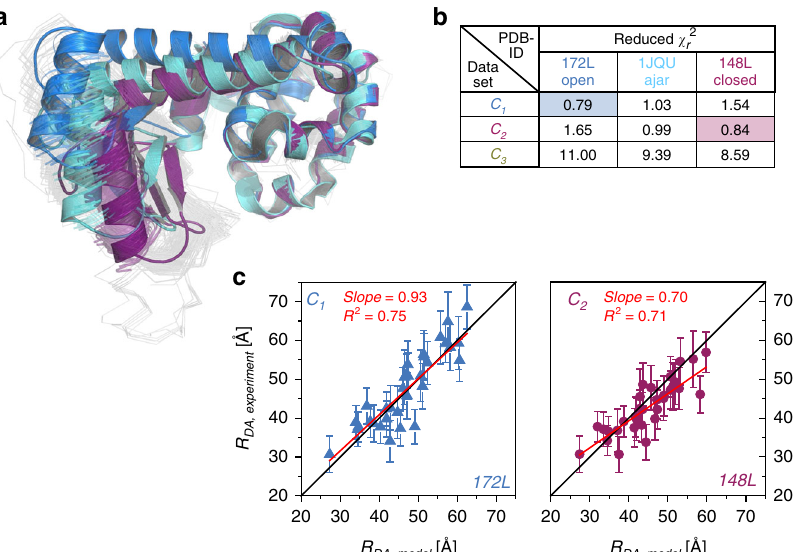
Fig. 5 PDB screening. a Overlay of the PDB structures used for screening. Blue, light blue and violet cartoons show the cluster representative of the open (172L), ajar (1JQU), and closed (148L) conformation of T4L. b Reduced χ 2 r for each distance set compared to the expected distances from the selected cluster representative. c The experimental distances R DA,experimental of the C 1 and C 2 dataset are plotted against the model distances R DA,Model from the best PDB structure representative and fi tted linearly (red lines). The black lines show a 1:1-relationship. Error bars shown are determined from the support plane analysis (95% con fi dence interval) shown in Fig. 4 and described in the text. physiological pH conditions (Fig. 6a, dashed trace), these dis- states 53 . The FRET-experiment with the variant S44pAcF/I150C tances exhibit a shortening that is consistent with the C 3 state, shows an increase in the population of C 3 at pH 2 (Fig. 6b), and the analogous DEER experiment at pH 3 shows a remarkably thus validating our conclusion that EPR and FRET do show the similar redistribution of interspin distances. Compared to excited state C 3 .